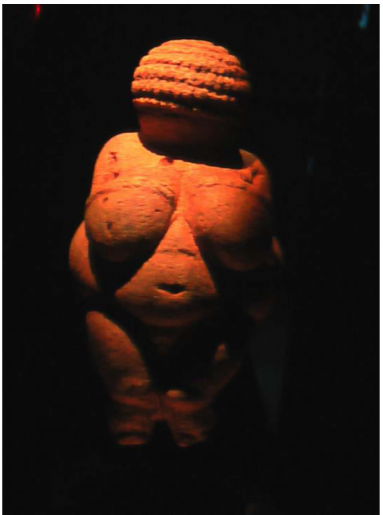
Figure 3. The Venus of Willendorf, a stone age symbol of fertility, estimated to be 24,000 to 22,000 years old, was once covered with red ochre (Natural History Museum, Vienna; photography by Helmut Tributsch).